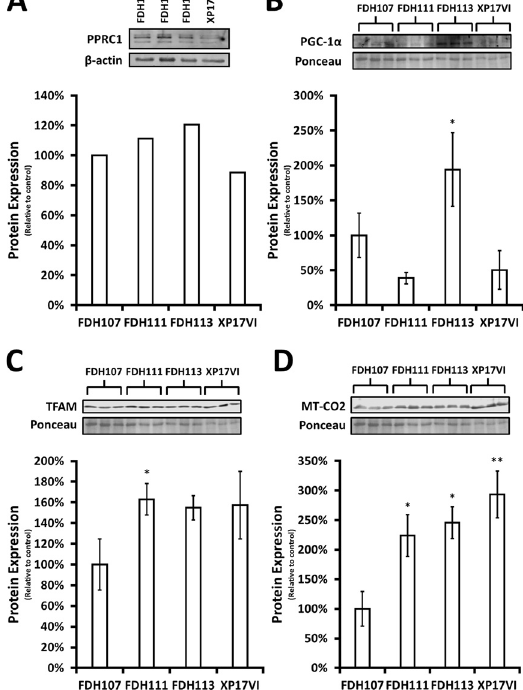
Figure 5 - Analysis of PGC-1 (cid:2) , PPRC1, TFAM and MT-CO2 protein levels in 4 cell lines. Protein levels from four primary human fibroblast cell lines, FDH107, FDH111, FDH113 and XP17VI, were assessed by immunoblotting. A) Protein levels of PPRC1, B) PGC-1 (cid:2) (mean±SD, n=3), C) TFAM (mean±SD, n=3) and D) MT-CO2 (mean±SD, n=3). FDH107 was set as reference (100%). * p <0.05 and ** p <0.01 compared to FDH107 cell